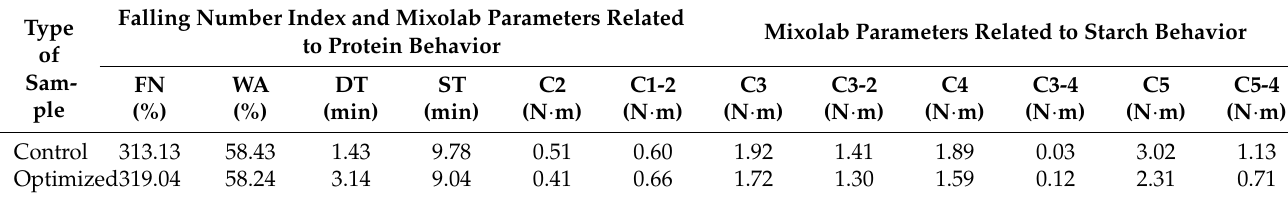
Table 4. Features of wheat dough control and optimized buckwheat-wheat